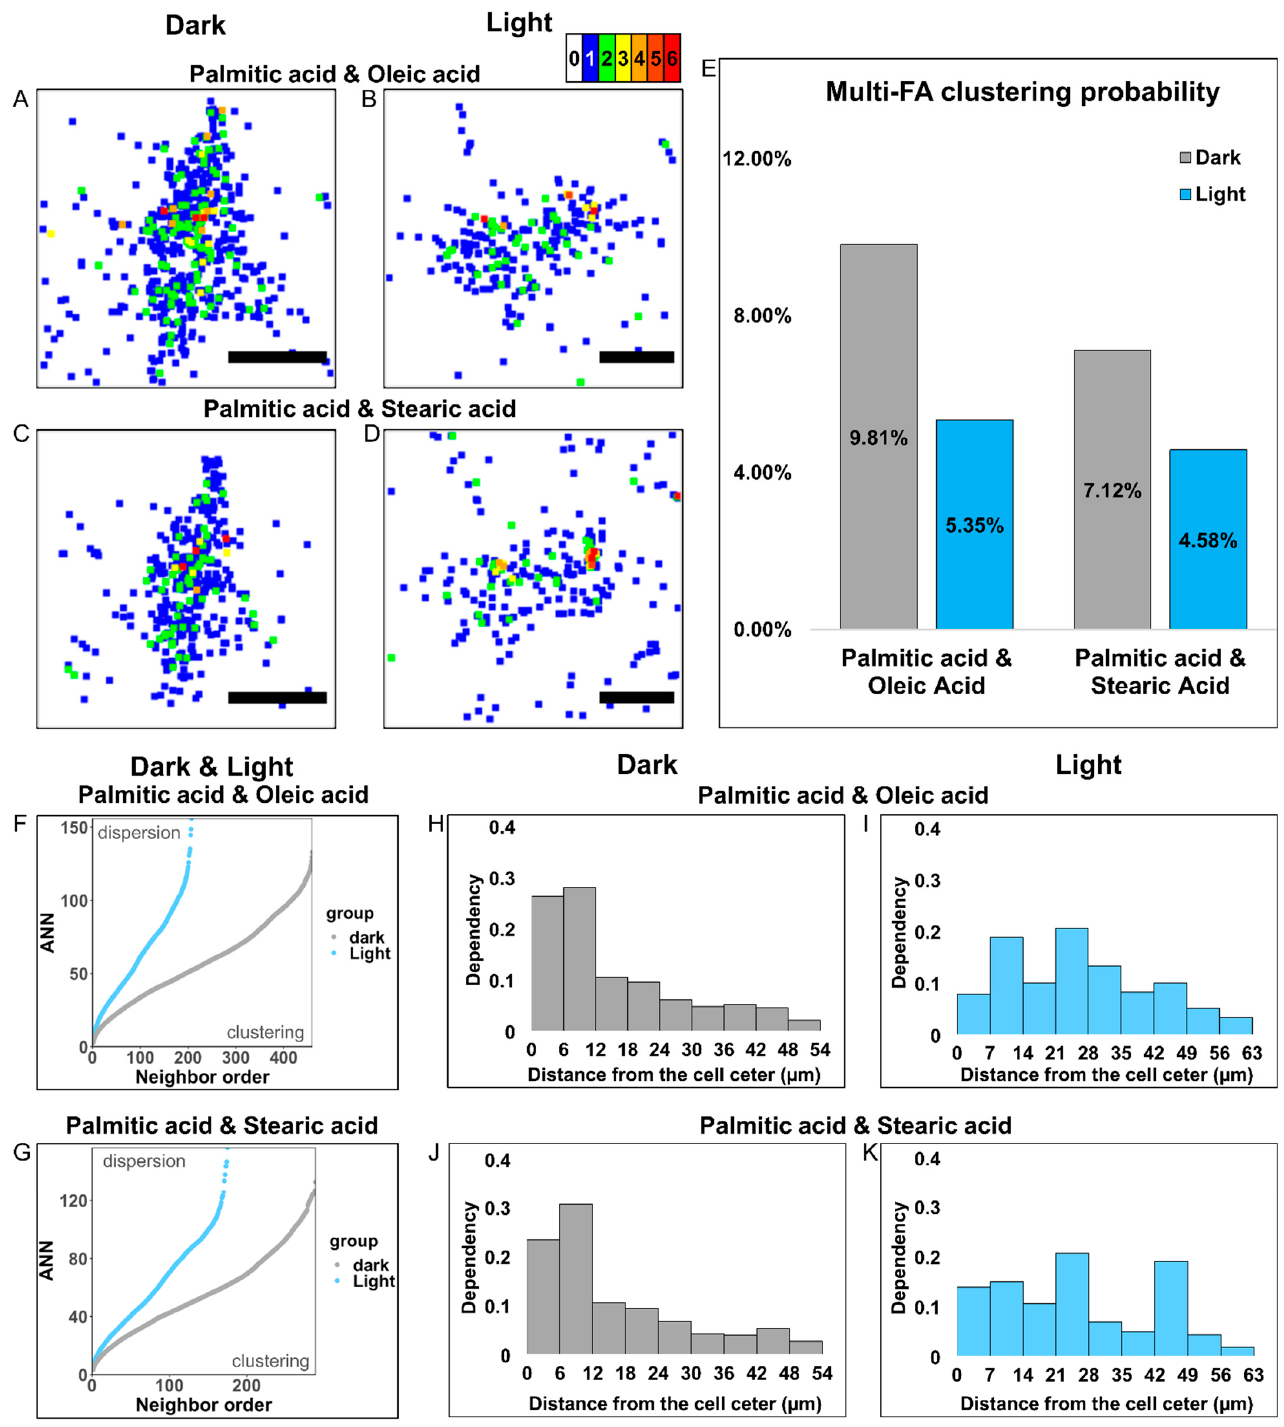
Figure 6. Imaging and manipulation of multi-FA clusters. ( A – B ) The heat map imaging of the multi- FA clusters formed by PA and OA. ( C – D ) The heat map imaging the multi-FA clusters formed by PA and SA. ( E ) The bar graph shows the probabilities to form multi-FA clusters by PA and OA/SA under dark and light conditions. ( F – G ) The ANN curves of multi-FA clusters formed by PA and OA/SA under dark and light conditions proves that they exists as clusters. ( H – I ) The density histograms show the distribution of PA-OA-formed multi-FA clusters under both dark and light conditions. ( J – K ) The density histograms show the distribution of PA-SA-formed multi-FA clusters under both dark and light conditions. Scale bars: 25 μ m.